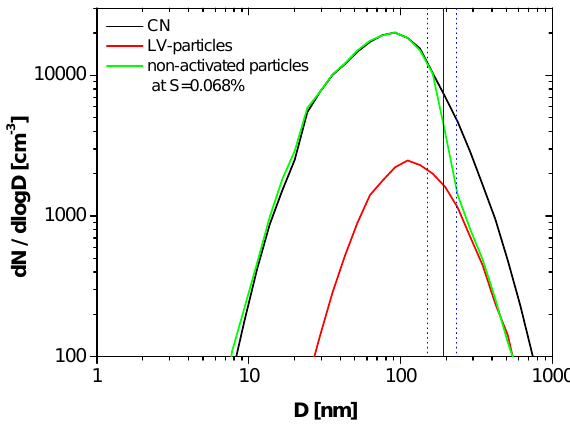
Fig. 6. Campaign median number size distributions of CN (black), of the externally mixed LV-particles (red), and of the non-activated particles at S = 0 . 068% (green). The blue solid line indicates where the median activation diameter D a is located. The blue dashed lines denote the location of D a − 3 σ a and D a + 3 σ a .